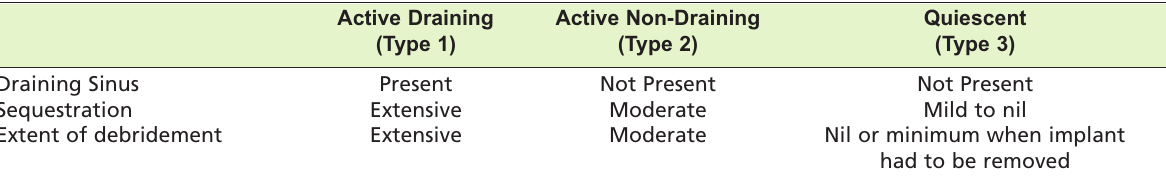
Showing Classification of Infected non-union and extent of debridement done Table I: